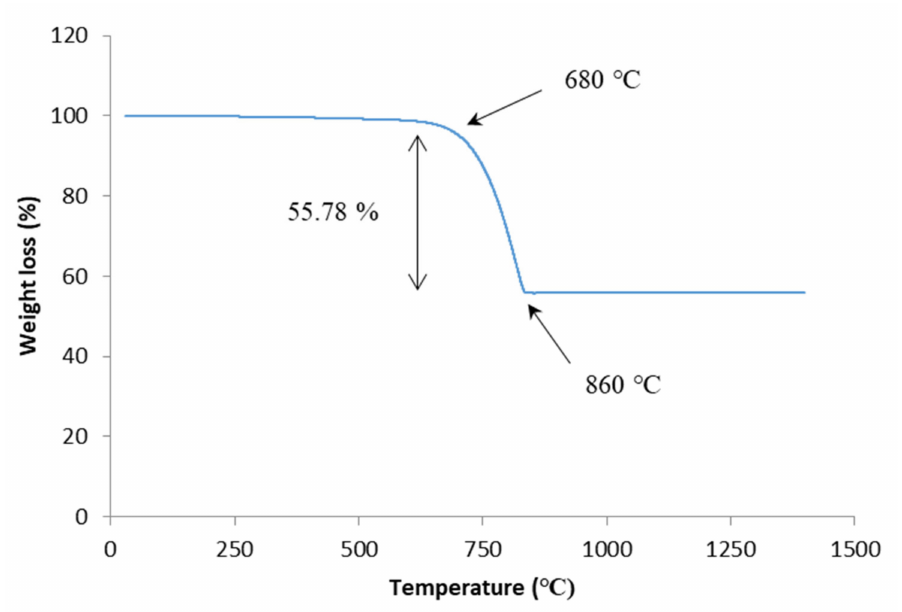
Figure 3. The TGA result of ACS weight loss against